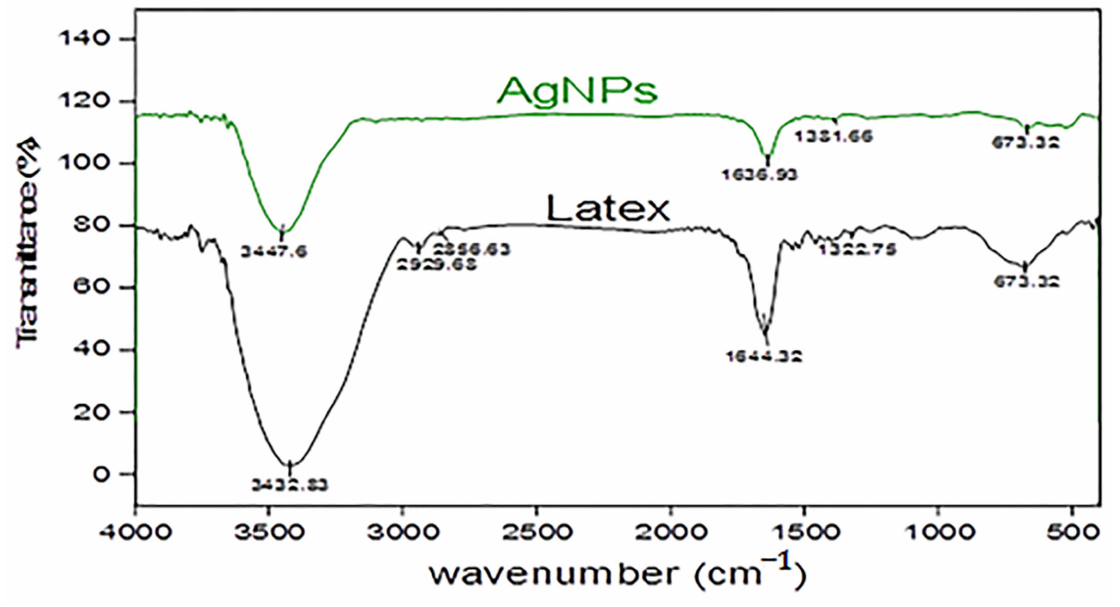
Figure 3. FTIR spectrum of C. acutum crude latex compared to that of synthesized AgNPs.